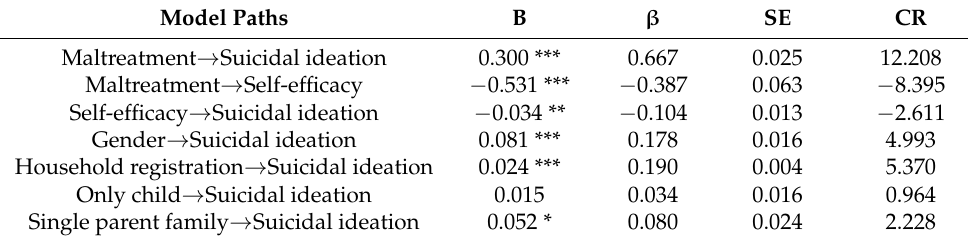
Table 4. Results of structural